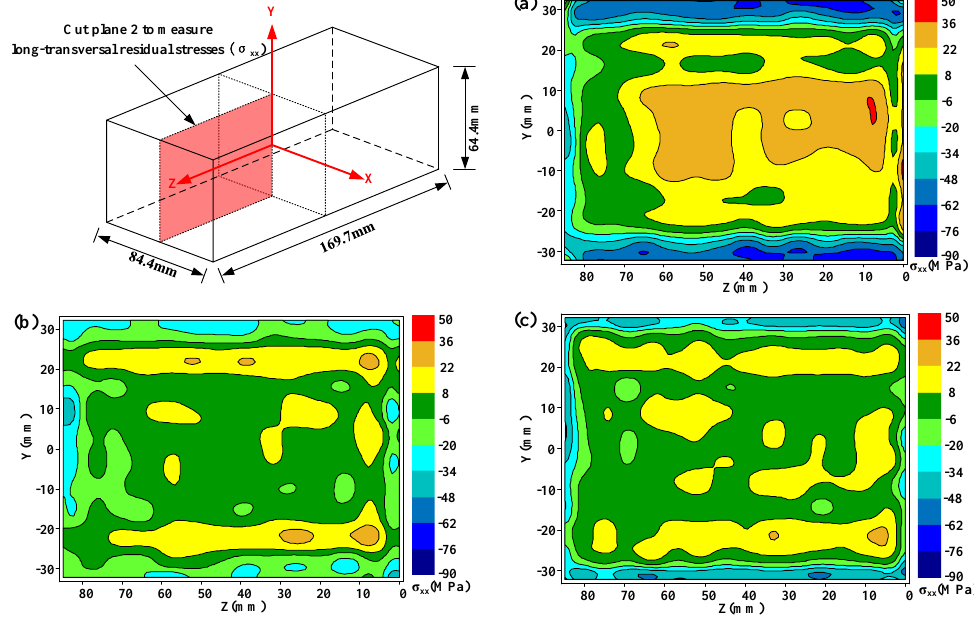
Figure 7. Longitudinal residual stresses ( σ zz ) on cut plane 1 in three different conditions: ( a ) as- quenched specimen; ( b ) heat-treated specimen; ( c ) cold-treated specimen.